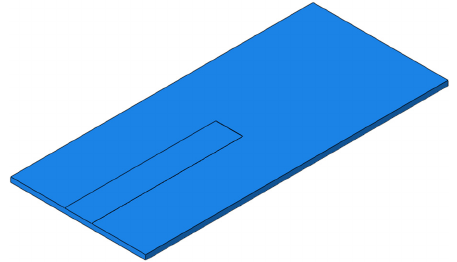
Figure 22. The TMP of SCC.